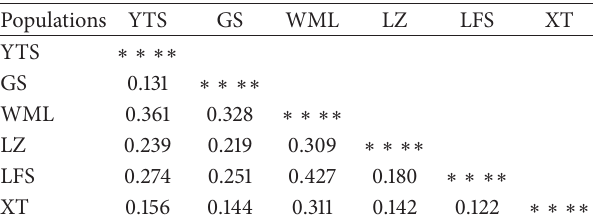
Table 4: Genetic differentiation of PhiPT analysis between popula- tions.